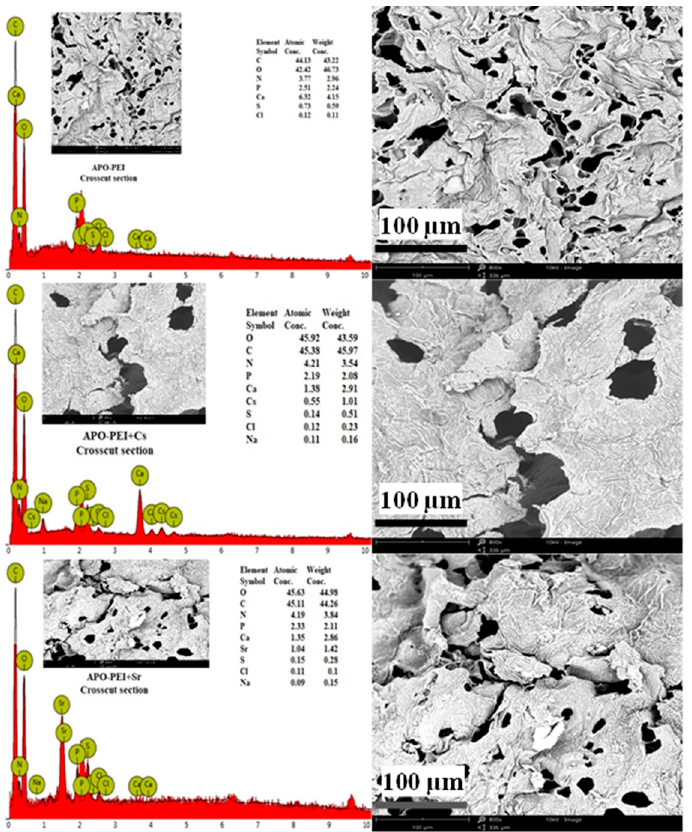
Figure A7. SEM-EDX analysis of cross-sections of APO-PEI sorbent before and after Cs(I) and Sr(II) sorption.